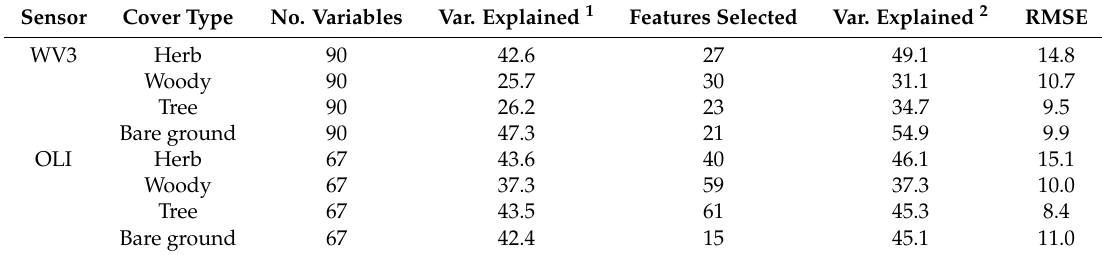
Table 3. Random Forest percent cover model results from WV3 and OLI sensors with and without RFE predictor variable selection.